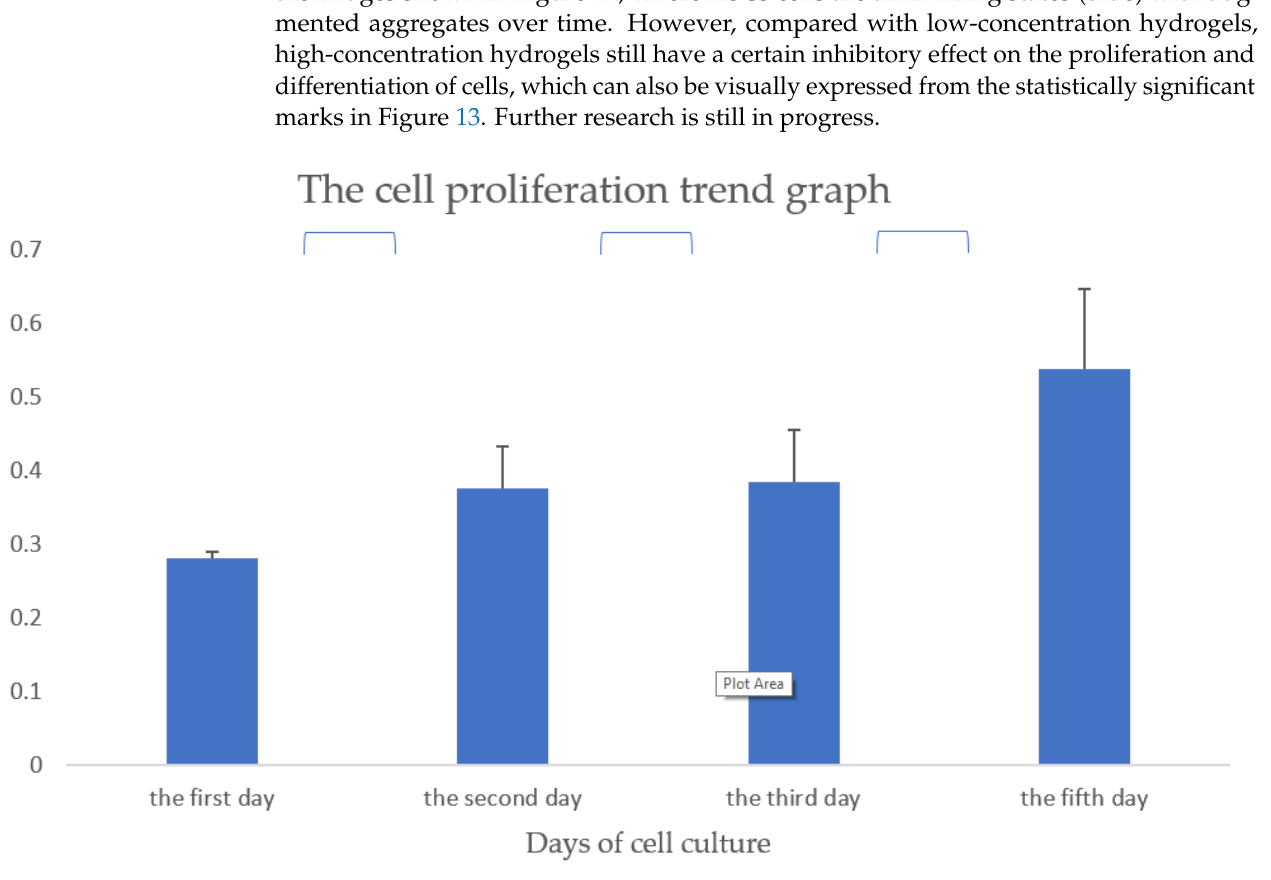
Figure 13. Cell proliferation trend graph of hydrogel composed of 15% gelatin, 2% sodium alginate, and 0.2% agarose. * means that there are statistical significances between the two adjacent culture days.